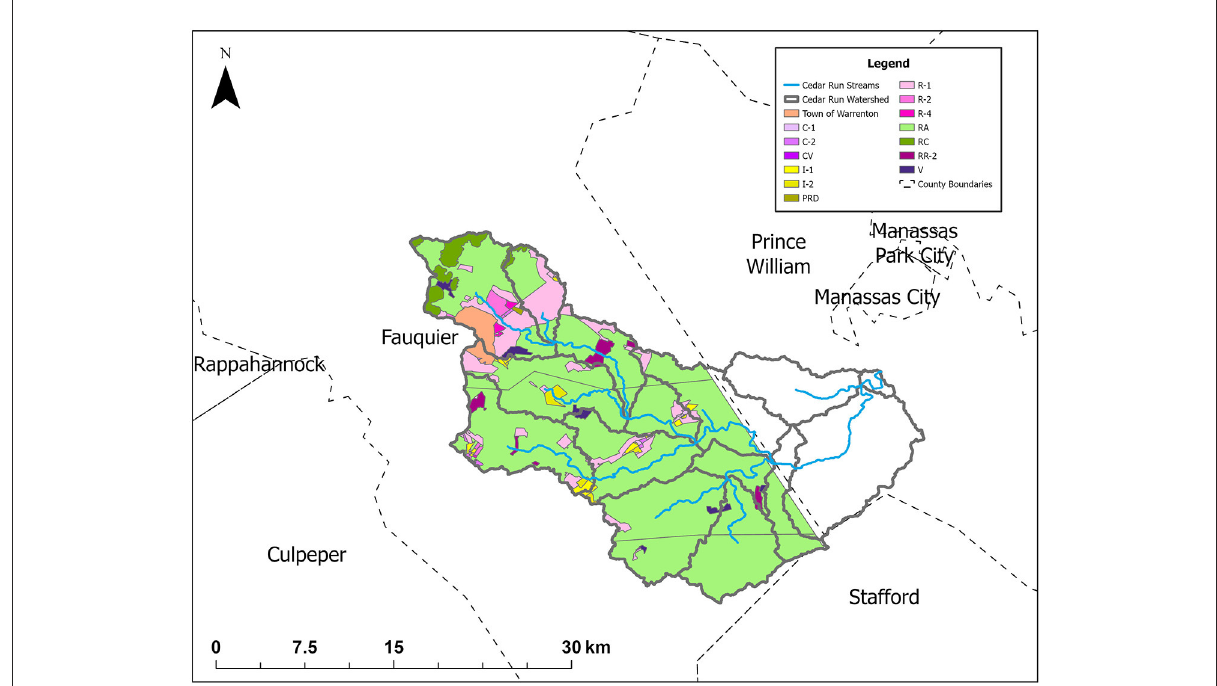
FIGURE1 Zoning configuration of Fauquier County that lies within the segments of Cedar Run Watershed (outlined in solid gray). Agricultural Zones: (RA) rural agriculture, (RC) rural conservation. Non-agricultural Zones: (C-1) commercial neighborhood, (C-2) commercial highway, (CV) commercial village, (I-1) industrial park, (I-2) industrial general, (PRD) planned residential development, (R-1) residential 1 dwelling unit/acre, (R-2) residential 2 dwelling units/acre, (R-4) residential 4 dwelling unit/acre, (RR-2) rural residential, (V)